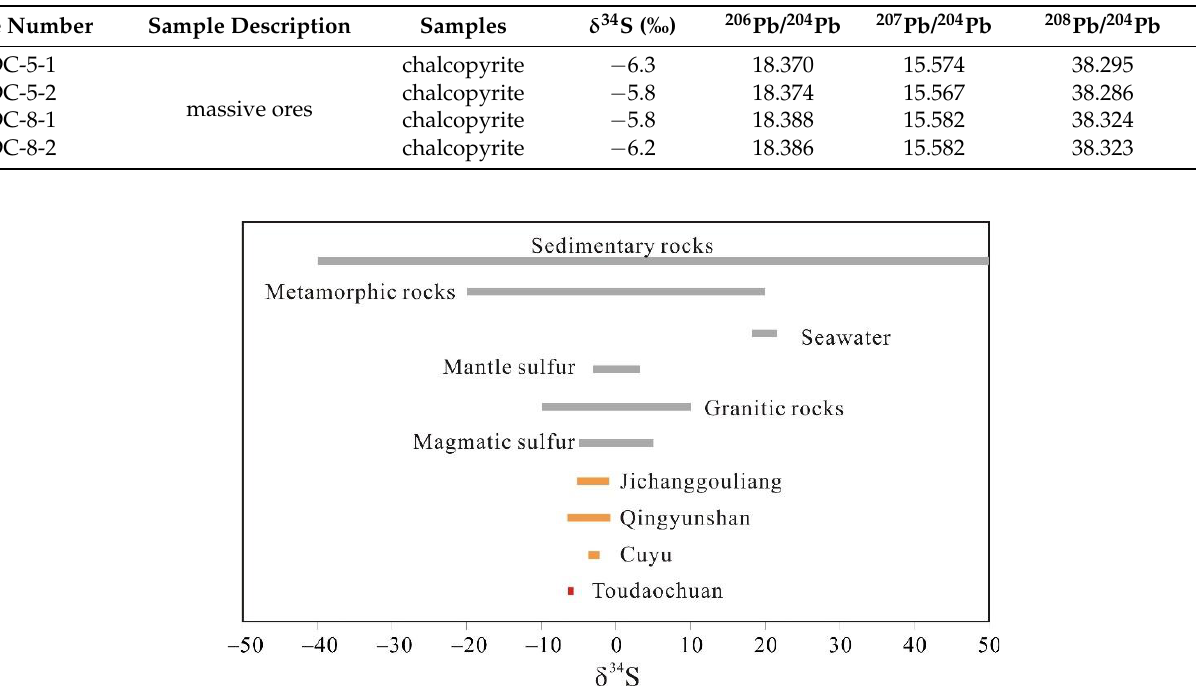
Figure 10. Ranges of the δ 34 S values of selected geologically important sulfur reservoirs and com- parison of δ 34 S values between representative deposits and the Toudaochuan deposit (after Zhang et al. [52] and Hoefs et al. [53]).